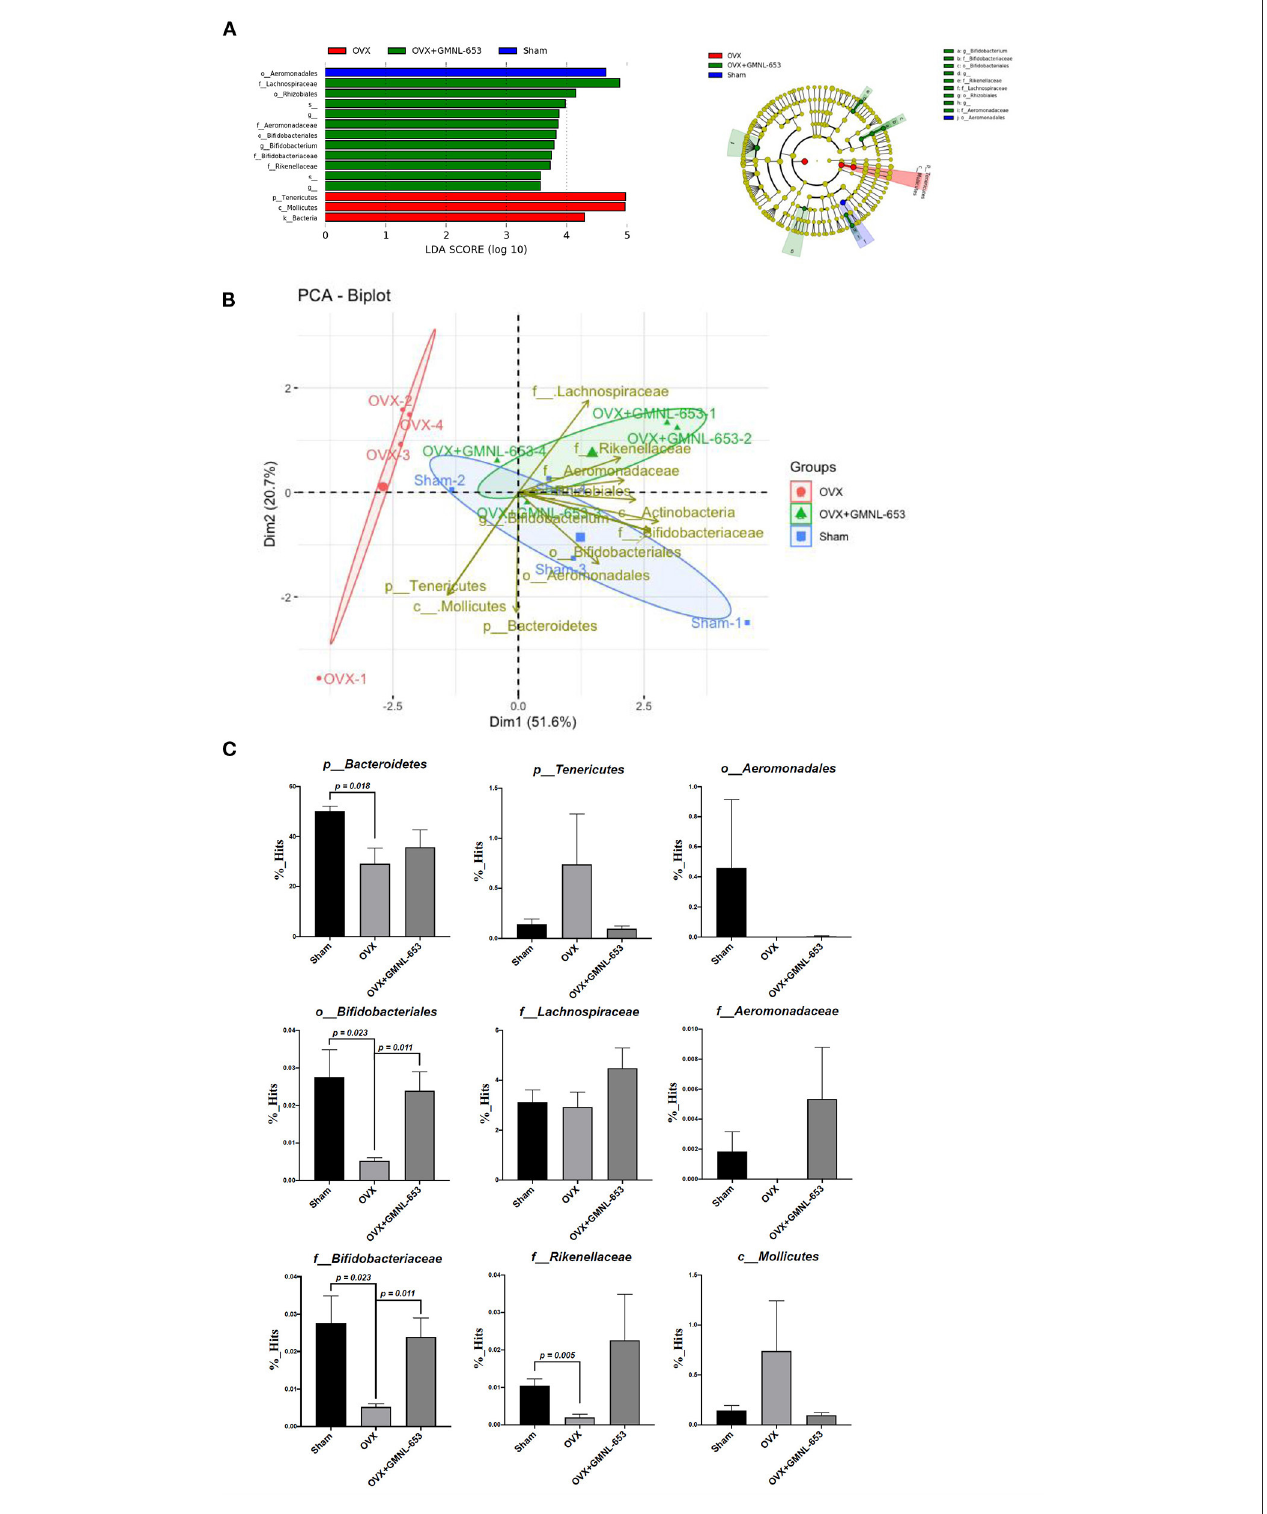
FIGURE 5 | Taxonomic differences and relative abundance of fecal microbiota in the sham and OVX mice treated with either the vehicle (H 2 O) or heat-killed GMNL-653. (A) Linear discriminant analysis and cladogram revealed the phylogenetic distribution of fecal microbiota associated with the sham, OVX, and OVX + GMNL-653 groups. The biplot of the principal component analysis (B) and relative abundances (C) of bacterial communities in the sham, OVX, and OVX + GMNL-653 groups.